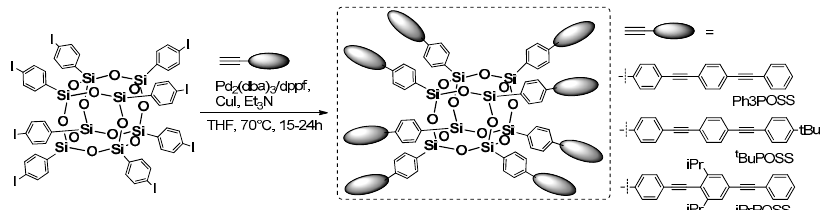
Figure 15. Synthesis route for octa-substituted T 8 phenylacetylenes obtained via Sonogashira reaction.